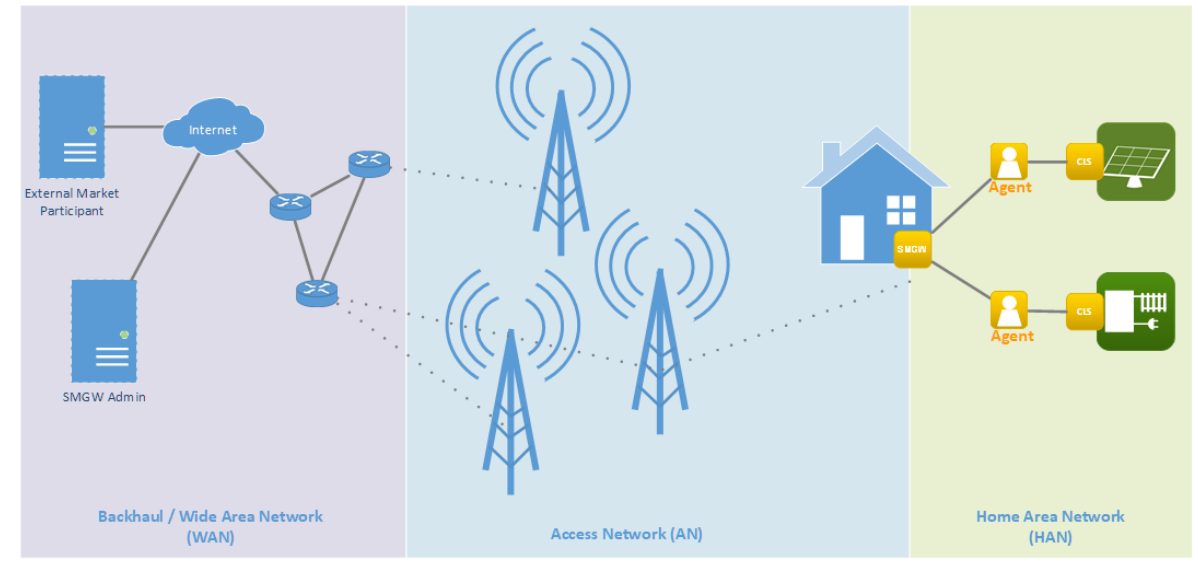
Figure 1. Smart Meter Infrastructure according to BSI [23] p. 27 and the utilization for our use case: agents represent single decentralized generators (DGs) and communicate via the Smart Meter Gateway (SMGW) infrastructure with each other using a wireless